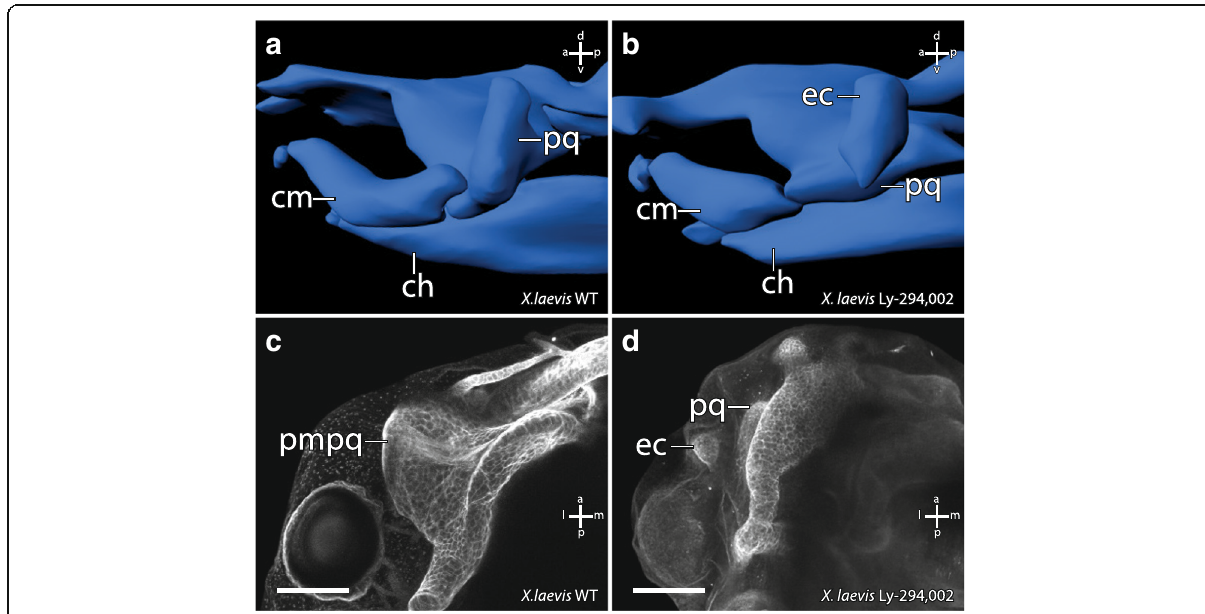
Fig. 6 Effect of Ly-294,002 injection into mandibular arch precursors on cartilaginous cranial morphology in X. laevis larvae. 3D-reconstructions based on confocal laser scanning microscopy of a control and b injected specimens at ZO 17 in lateral view. Maximum intensity projections of c control and d injected specimens at ZO 20 stained with monoclonal II6B3-collagen II antibody and Alexa 568 in dorsal view. The reduction of the processus muscularis and the presence of an ectopic cartilage can be observed in injected specimens. ch, ceratohyal; cm, Meckel ’ s cartilage; ec, ectopic cartilage; pmpq, processus muscularis of the palatoquadrate; pq, palatoquadrate. Scale bar 200 μ